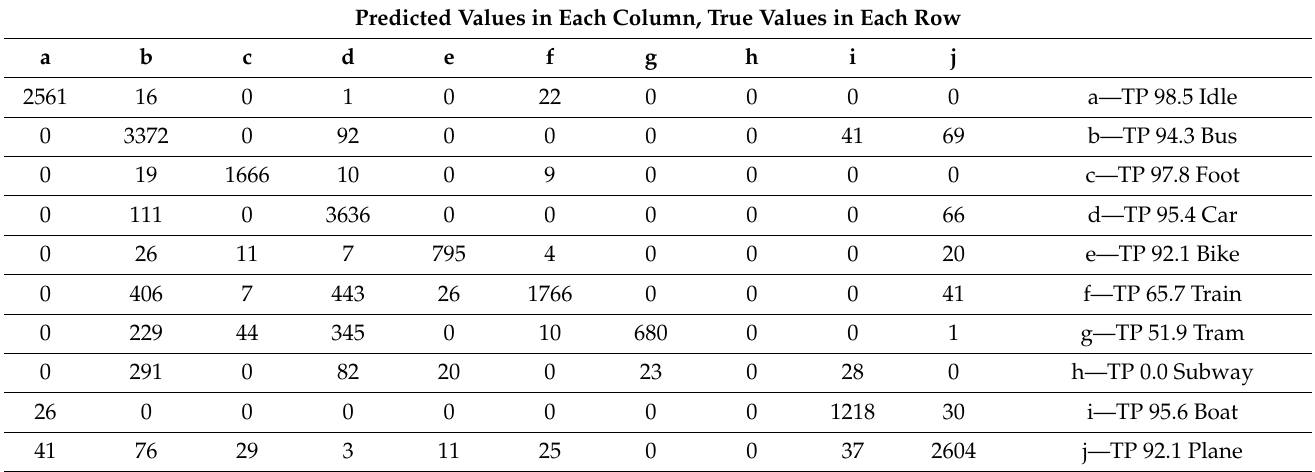
Table 9. Confusion matrix for normalised acceleration values (2-fold cross-validation, RF, HSS30). Predicted Values in Each Column, True Values in Each Row